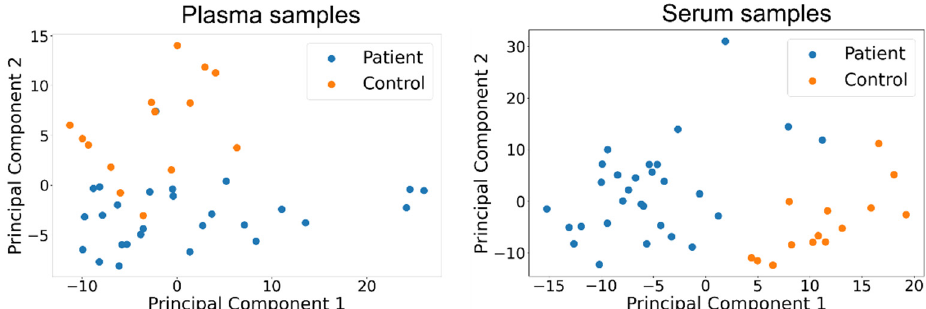
Figure 3. Score-score plots for the first two principal components obtained from plasma and serum samples LOOCV analysis.